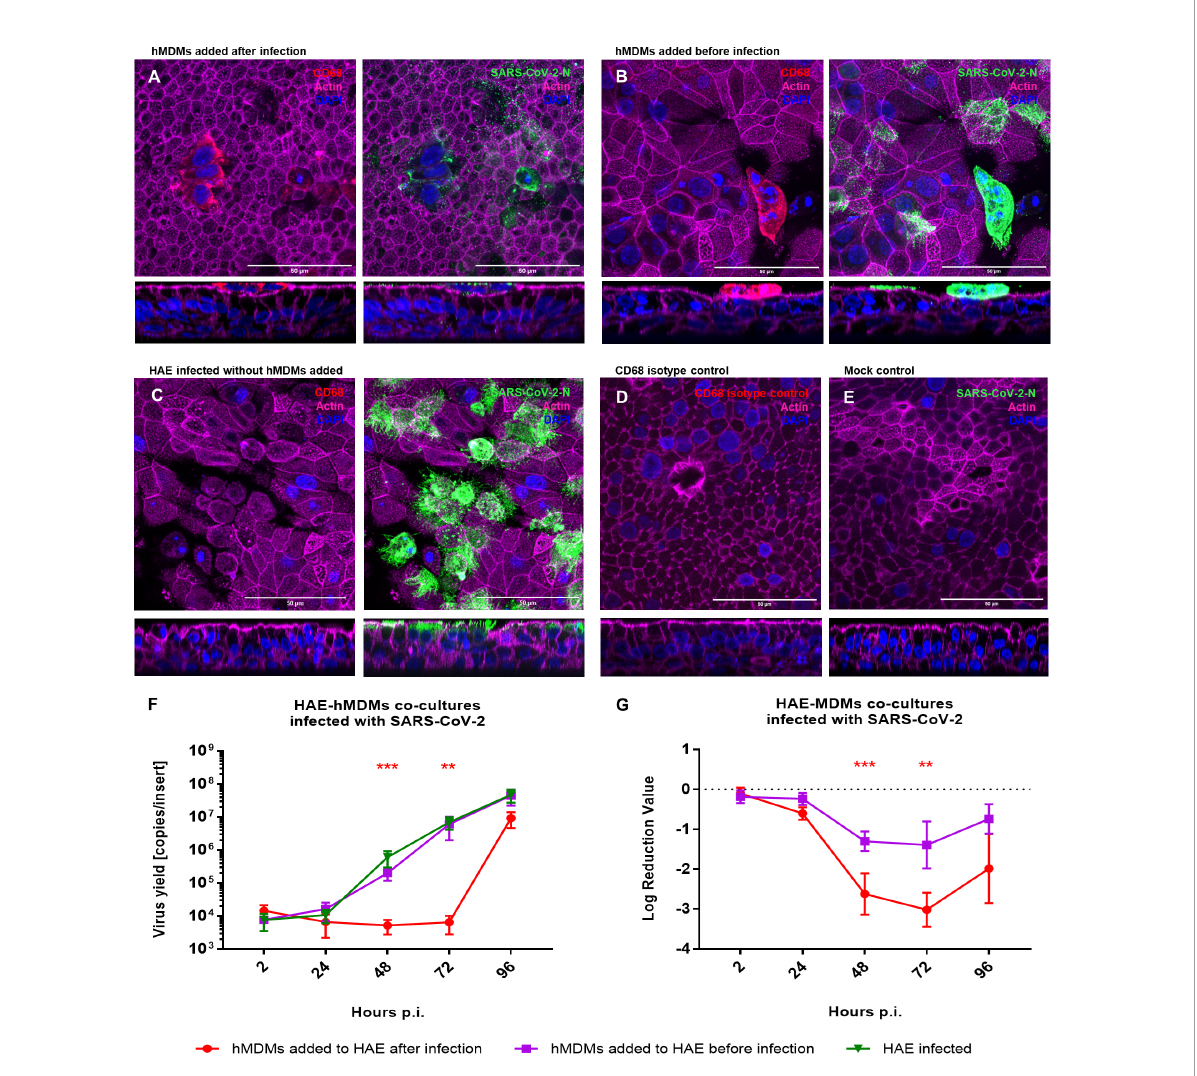
FIGURE 3 HAE-hMDMs co-cultures infected with SARS-CoV-2. hMDMs were added to the HAE before and after SARS-CoV-2 infection. (A, B) Confocal images of HAE-hMDMs co-cultures and (C-E) controls. Co-cultures were fi xed 72 h p. i. and stained for CD68 (red left panels), virus (green right panels), actin (magenta) and nuclei (blue). Corresponding orthogonal views are shown below each image. (F, G) graphs showing the quanti fi cation of viral replication in co-cultures, evaluated by RT-qPCR. Data were obtained from three independent experiments, each experiment was carried out in triplicate and means ± SEM is shown. (F) shows virus yields expressed as RNA copies per millilitre, (G) shows the log reduction value of viral RNA in HAE-hMDMs co-cultures calculated using the values of the infected HAEs without hMDMs as value zero. Groups were compared by the Kruskal-Wallis test and Dunn ’ s multiple comparisons test. **p<0.01,